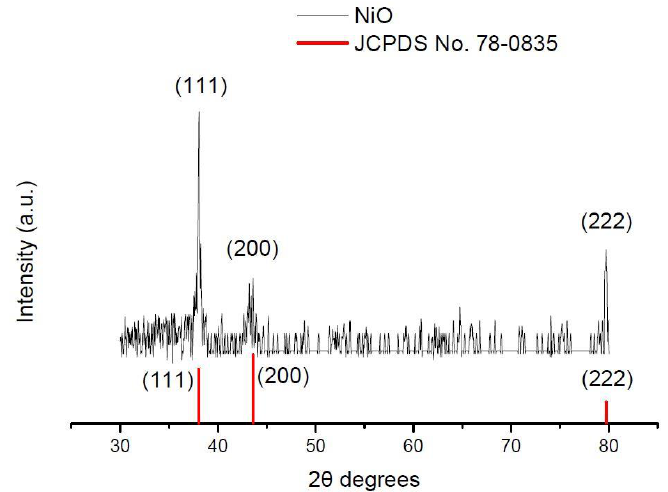
Figure 3. XRD pattern of the NiO film.